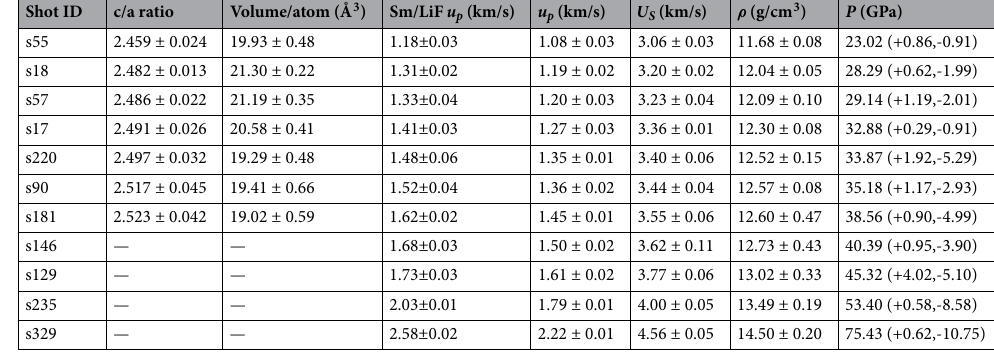
Table 1. Experimentally determined lattice parameters and Hugoniot states of shocked Sm. The volume is calculated using the lattice parameters obtained from x-ray diffraction measurements. Therefore, the volume for the liquid phase is not determined as extraction of volume for liquid data still remains a challenge. Density ( ρ ), and pressure ( P ) are determined from the Hugoniot jump conditions and Monte Carlo impedance 3 matching technique. The initial density was 7.536 g/cm with an uncertainty of 0.3%. The upper bound of the pressure error is from impedance matching and lower bound is from incremental impedance matching. On no shots did the shock pressure, at times later than the initial breakout into the LiF window, exceed the initial pressure from impedance matching.